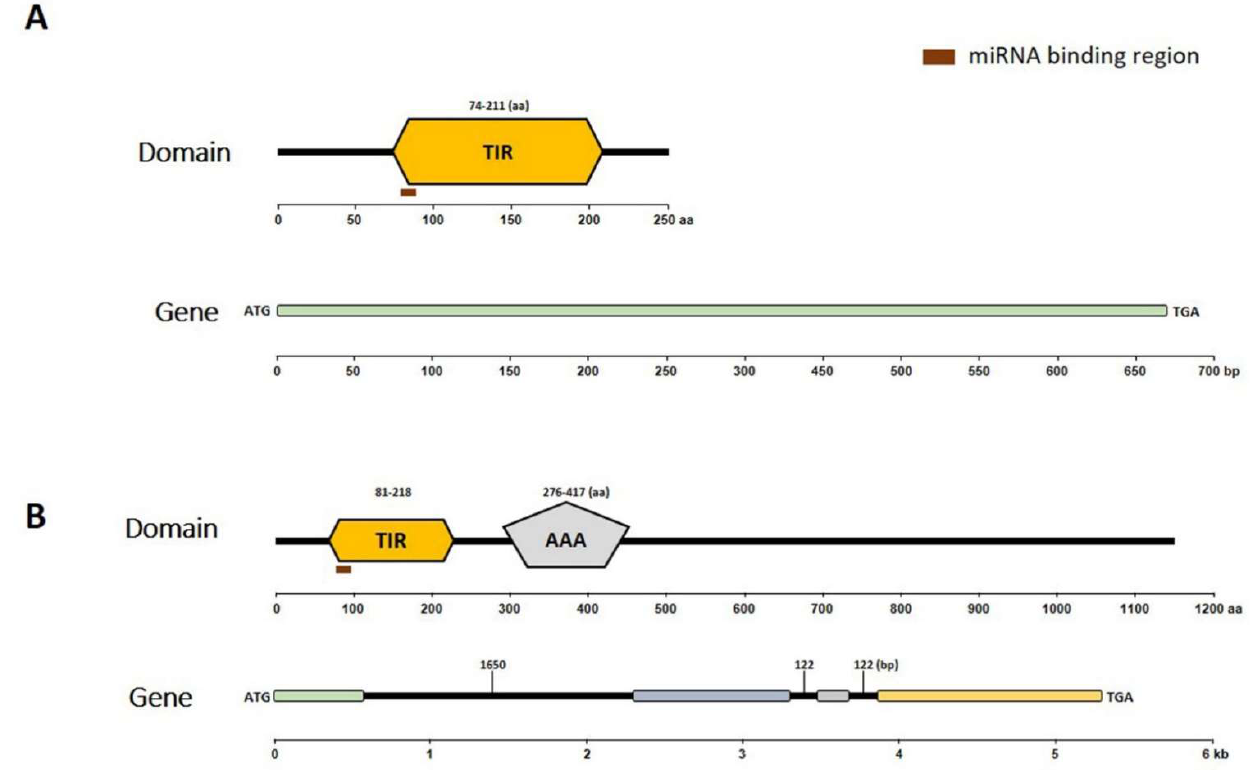
Figure 3. Analyses of conserved domains in putative proteins as well as gene structures. ( A ) Bra019412 encodes only the TIR domain, whereas ( B ) Bra019410 encodes the TIR and AAA